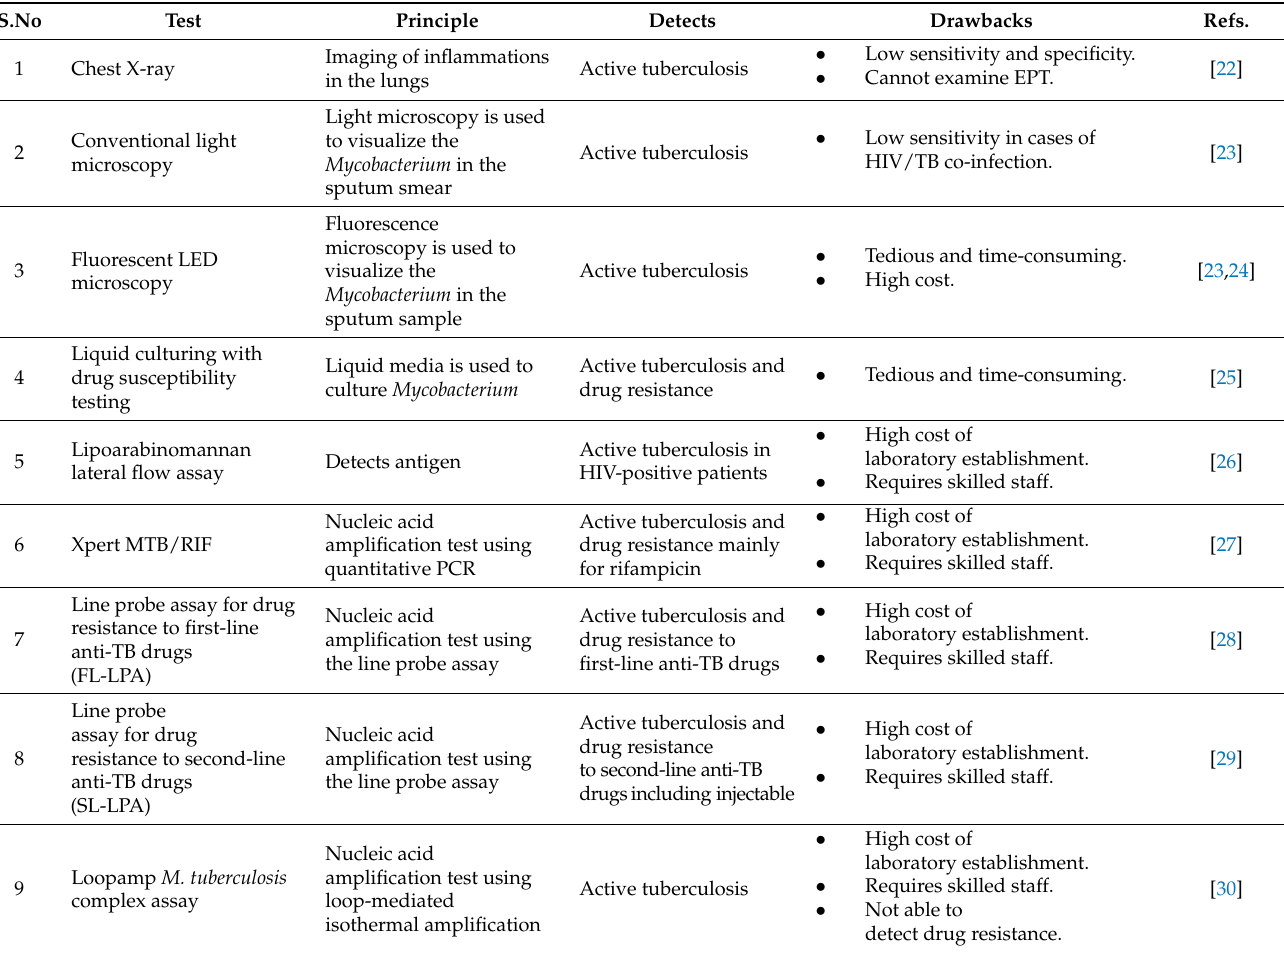
Table 1. Limitations of conventional methods used in TB